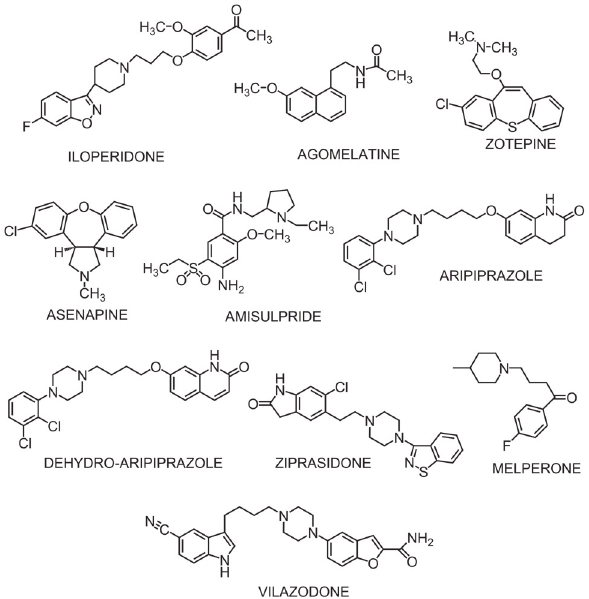
Fig. 1. Structures of selected antidepressants and antipsychot-